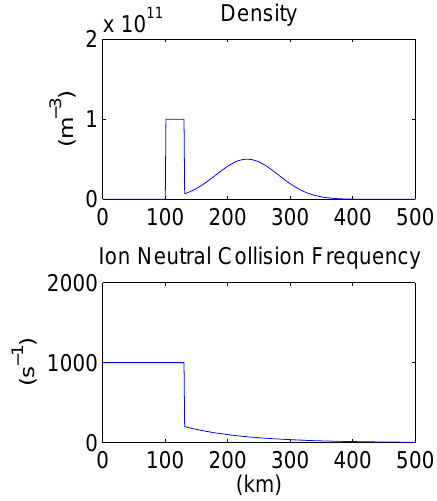
Fig. 1. Alfv´en velocity (solid line) and phase velocity for Alfv´en waves (red dashed line) in a representative ionosphere, and up to 3 R E . The horizontal dashed line at 200 km marks the top of the E-region ionosphere, and the input to the “magnetospheric trans- mission line.”